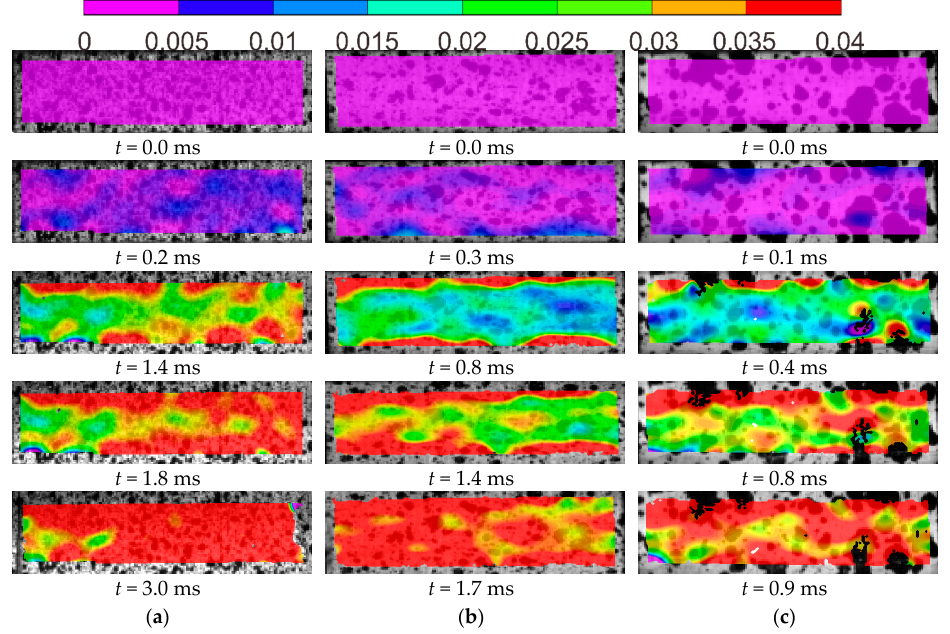
Figure 8. Normal strain distribution of GFRP adherent at different loading rates: ( a ) 50 s − 1 ; ( b ) 100 s − 1 ; and ( c ) 200 s − 1 .